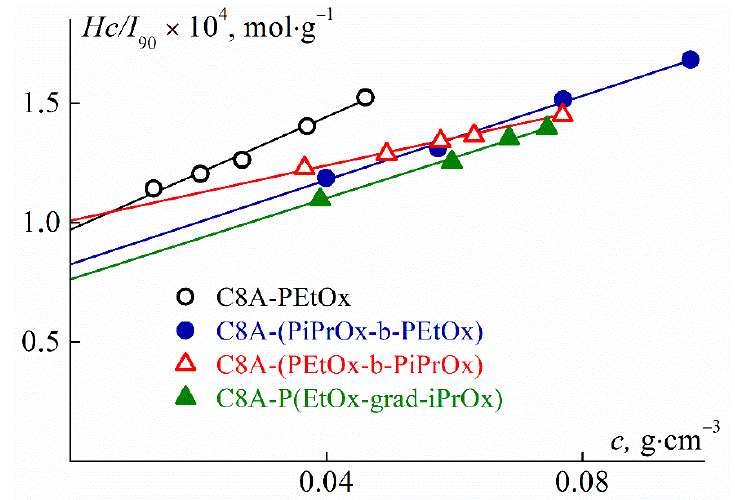
Figure 2. Concentration dependences of Hc / I 90 for the CA8-PAlOx solutions in 2-nitropropane. Table 1. Molar mass and hydrodynamic characteristics of star-shaped C8A-PAlOx.